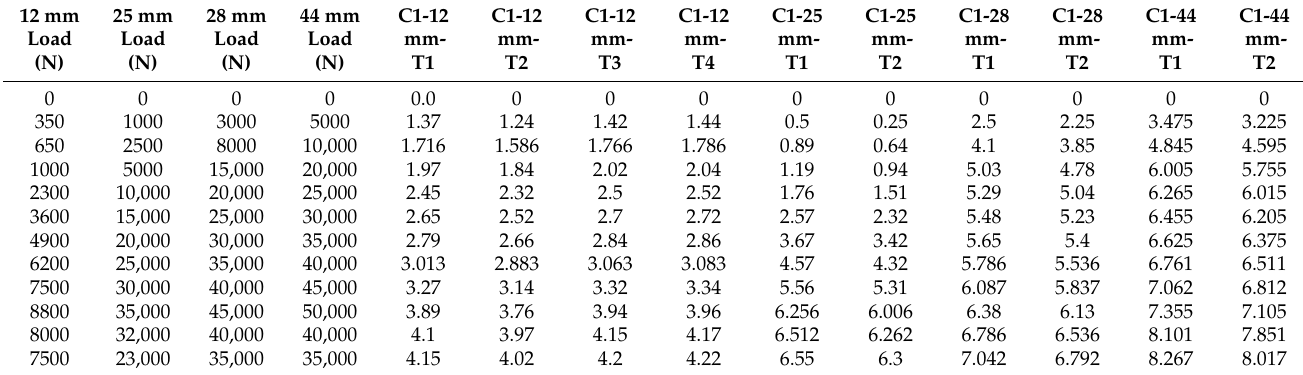
Table A1. Peak force and associated displacement for punch test cell 1 (C1).